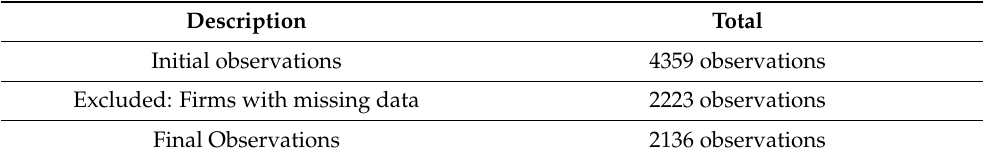
Table 1. Sample selection criteria.